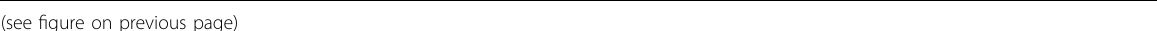
Fig. 2 CircPKNOX1 delayed the process of disc degeneration in vitro. A RT-qPCR was used to detect the transfection ef fi ciency of circPKNOX1 siRNA #1, 2, and 3; ** P <0.01. Data represent mean ±SD, and the P values were determined by a two-tailed unpaired Student ’ s t test. B After knocking down circPKNOX1, the expression level of PKNOX1 was detected. Data represent mean±SD, and the P values were determined by a two-tailed unpaired Student ’ s t test. C Adenoviruses containing circPKNOX1 were used to infect nucleus pulposus cells, and the infection ef fi ciency was detected; *** P <0.001. Data represent mean±SD, and the P values were determined by a two-tailed unpaired Student ’ s t test. D Green fl uorescence indicates infected nucleus pulposus cells. E After circPKNOX1 was knocked down or overexpressed, the expression levels of related proteins (collagen II, aggrecan, SOX9, MMP3, MMP13, ADAMTS4, and ADAMTS-5) were detected using western blotting. F The fl uorescence intensity of related proteins (collagen II, aggrecan, ADAMTS4, and MMP13) was observed using an immuno fl uorescence assay (scale bar, 100 μ m). After circPKNOX1 was knocked down ( G ) or circPKNOX1 was overexpressed ( H ), RT-qPCR was used to detect the expression of related genes; * P <0.05, ** P <0.01. Data represent mean±SD, and the P values were determined by a two-tailed unpaired Student ’ s t test. I Top: the extracellular matrix was detected by Alcian staining. Bottom: the Alcian staining was quantitatively analyzed. Data represent mean±SD, and the P values were determined by a two-tailed unpaired Student ’ s t